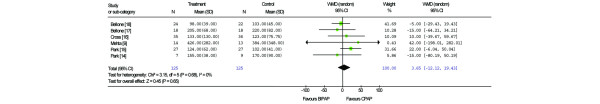
Forest plot: effect of BiPAP and CPAP on duration of noninvasive ventilation needed to resolve pulmonary oedema. BiPAP, bi-level positive airway pressure; CI, confidence interval; CPAP, continuous positive airway pressure; WMD, weighted mean difference.